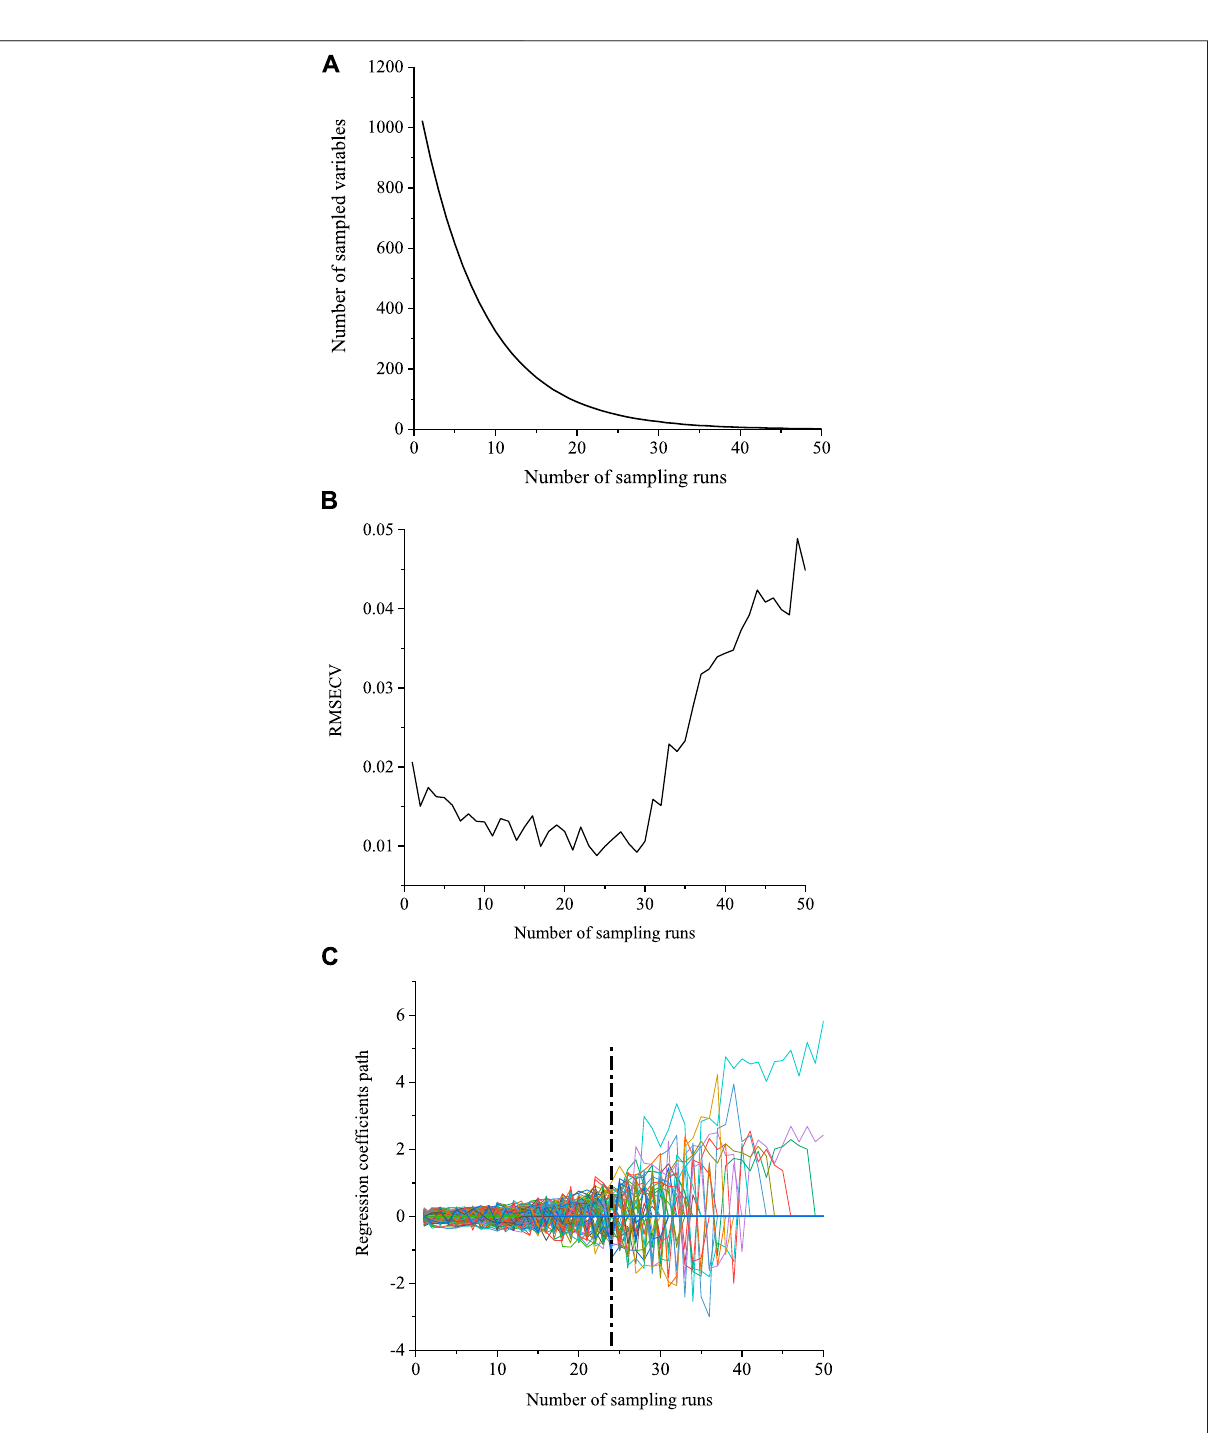
FIGURE 10 | (A) Number of THz sampling variables; (B) THz RMSECV; (C) THz regression coef fi